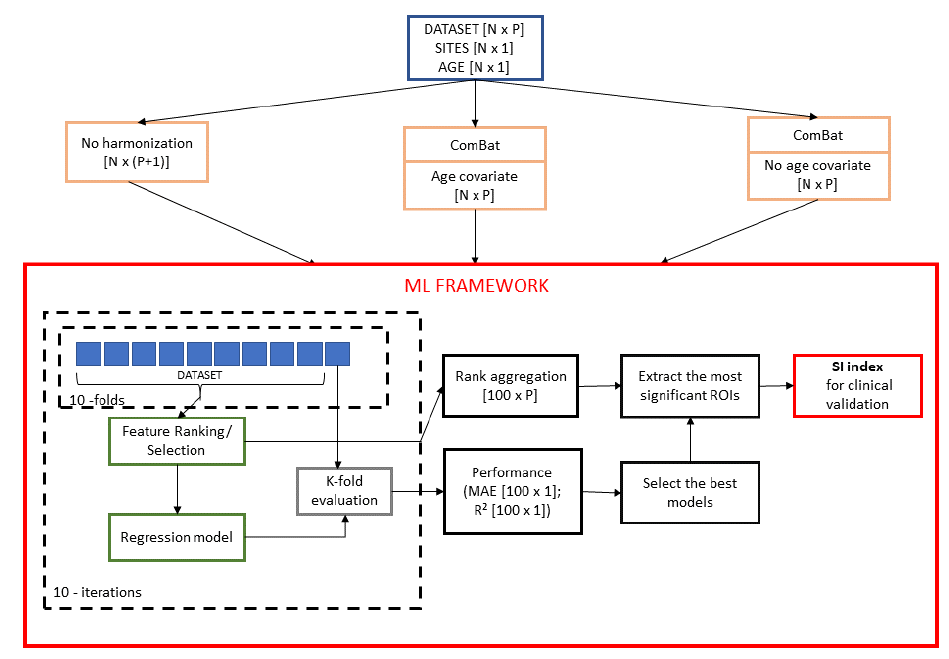
Figure 1. Statistical framework to compare the three harmonization strategies and select the most age-related predictive features. Three harmonization strategies were applied to each of the two dataset (i.e., NC and ASD). For each resulting dataset, a nested feature selection was performed on the training set in each round of the k-fold validation. Subsequently, 100 stepwise regression models were trained by progressive increasing the training set size. A consensus ranking procedure was used to select the most stable features with the lowest mean absolute error. This procedure was repeated for each of the three regression algorithms—SVR, RF, and Lasso—resulting in nine combinations of “harmonization strategy–regression model”. The performance of the models were compared in order to select the most effective machine learning algorithm for age prediction. For the best regression model, the sets of features that resulted from different harmonization strategies are compared using a stability index to quantify the effects of the harmonization and support clinical